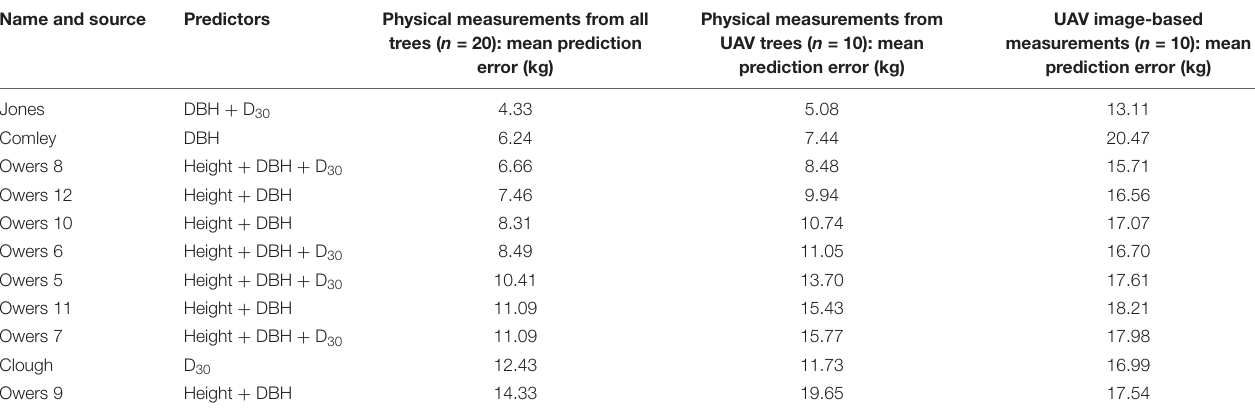
The table shows mean prediction error (kg) for each model, tested on three different sets of data: (1) the physically measured variables from all 20 harvested trees; (2) the measured variables from the 10 trees that were imaged by the UAV and (3) the predicted variables extracted or derived from the UAV imagery. Orange highlighting indicates the model with the best prediction accuracy across all three datasets. Mean prediction error was calculated for each model by averaging the difference between observed and model predicted tree biomass (in kg). The formulae for the allometric equations are provided in the ( Supplementary Table S6 ). Citations for the